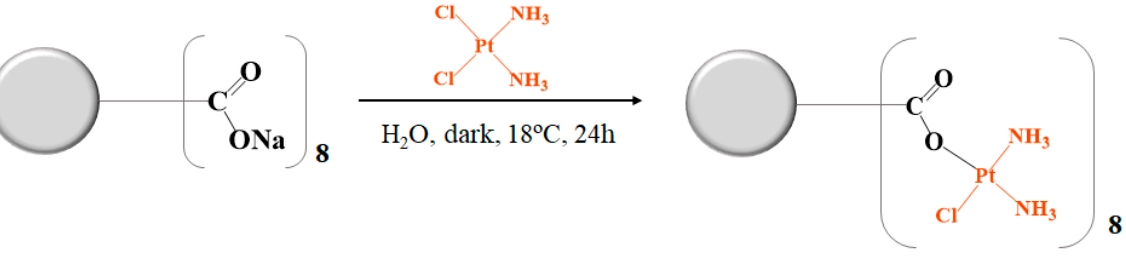
Scheme 1. Representation of the synthesis of the PAMAM dendrimer G0.5 functionalized with cisplatin in monodentate form, G0.5(COOPt(NH 3 ) 2 Cl) 8 . G1.5COONa PAMAM Dendrimer with Cisplatin–G1.5(COOPt(NH 3 ) 2 Cl) 16